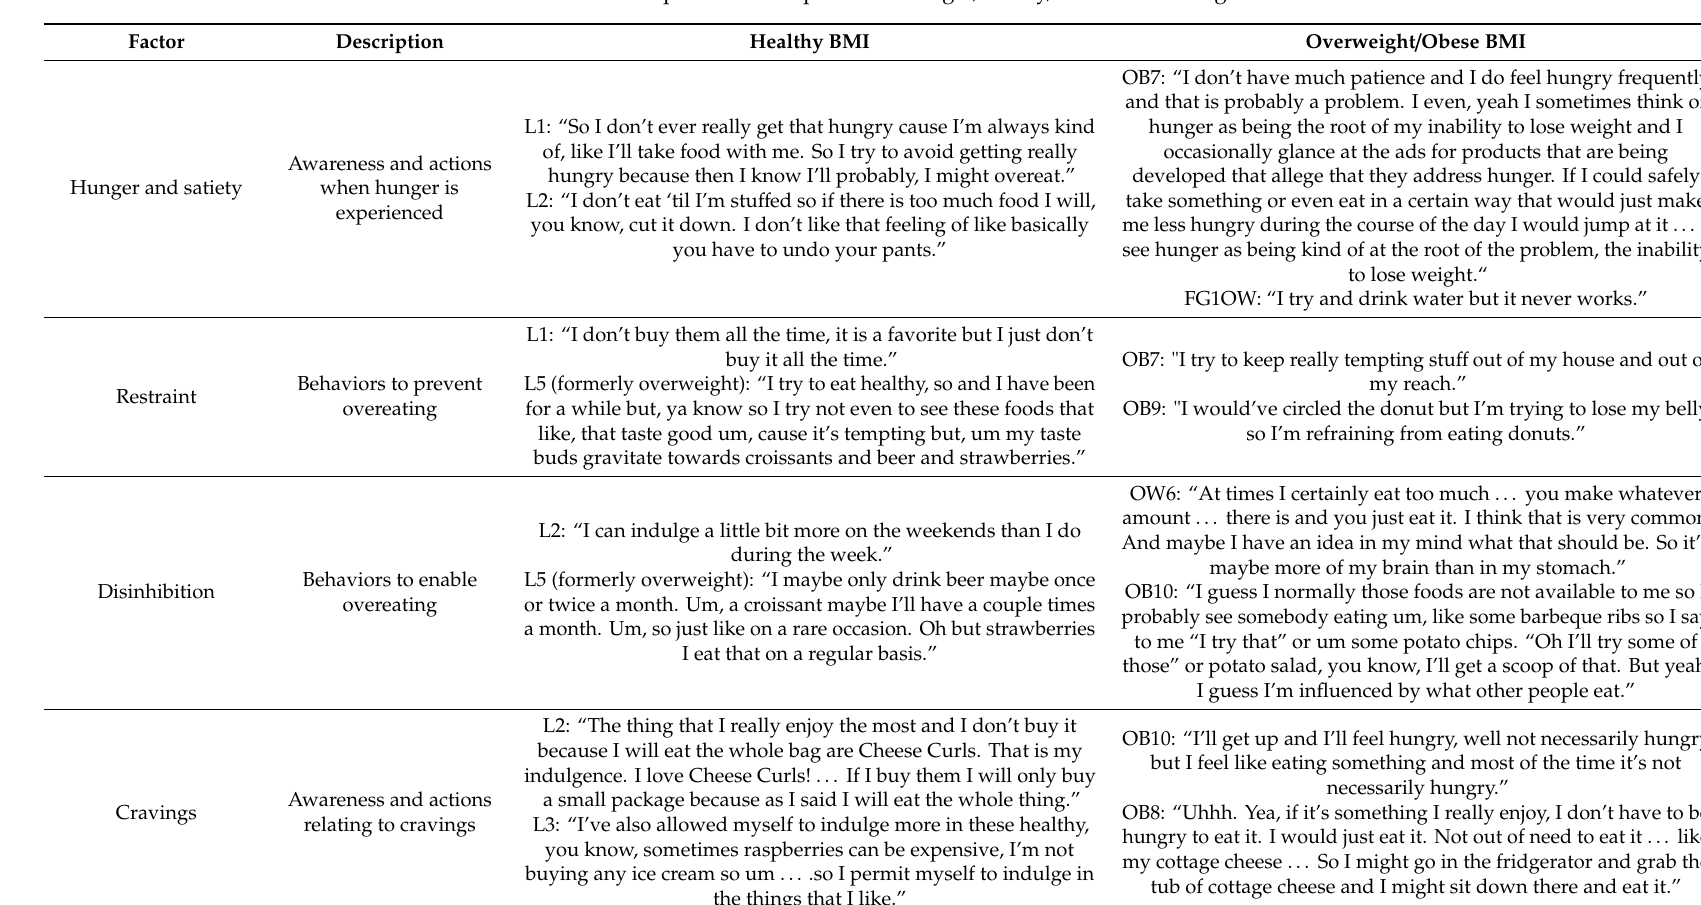
Table 2. Perceptions and responses to hunger, satiety, and food